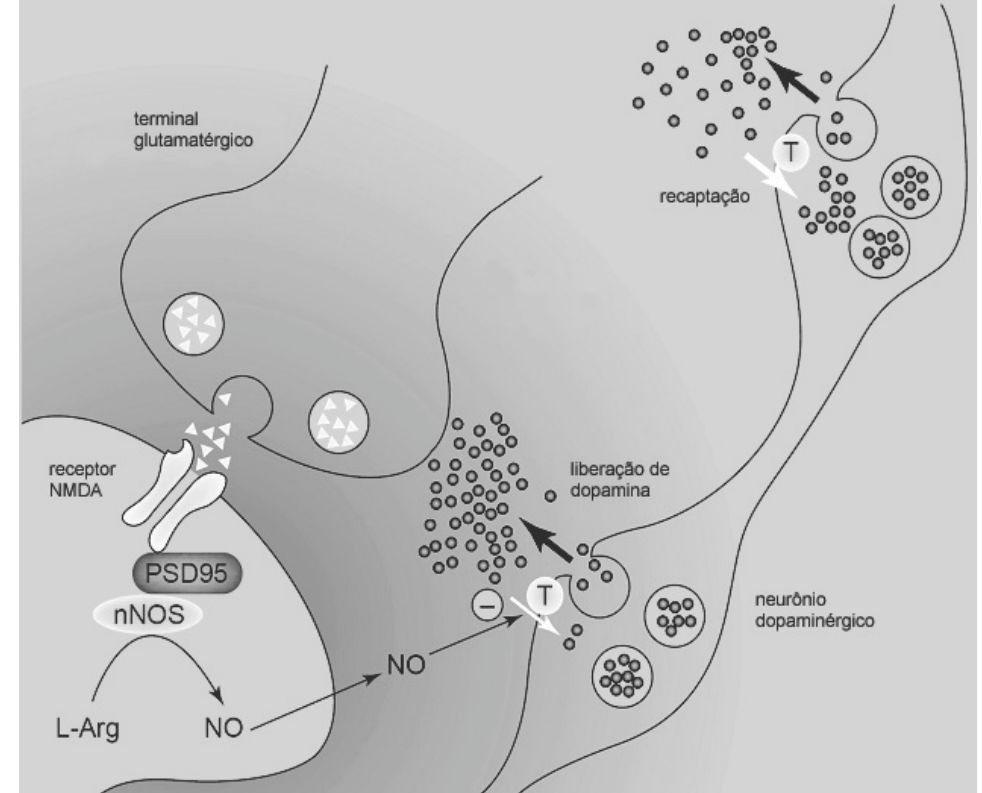
Figura 1 . Ilustração da liberação do NO a partir da ativação dos receptores glutamatérgicos do tipo NMDA e sua interferência na terminação dopaminérgica. A liberação do glutamato ativa os receptores glutamatérgicos NMDA pós-sinápticos e promove influxo de Ca + , que ativa a enzima NOS e estimula a formação do NO, a partir do aminoácido L-arginina. O NO liberado inibe a atividade do transportador de dopamina, diminuindo a sua recaptação e aumentando sua liberação nas terminações dopaminérgicas próximas às sinapses glutamatérgicas. Modificado de Kiss e Vizi